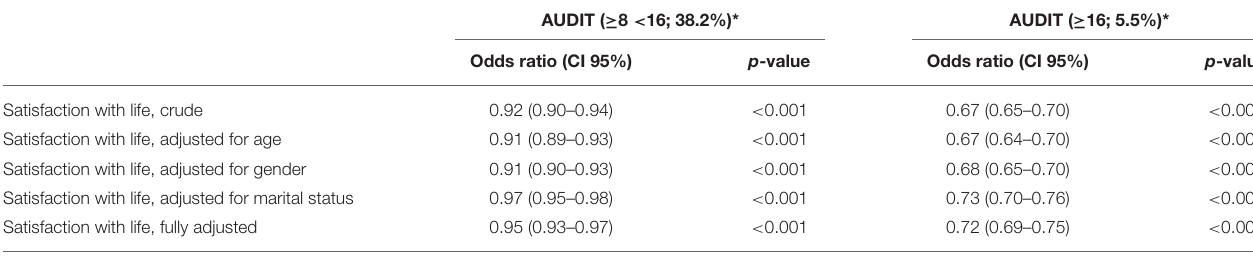
TABLE 4 | Crude and adjusted association between mental health problems (HSCL-25) and potential alcohol-related problems (AUDIT ≥ 8).